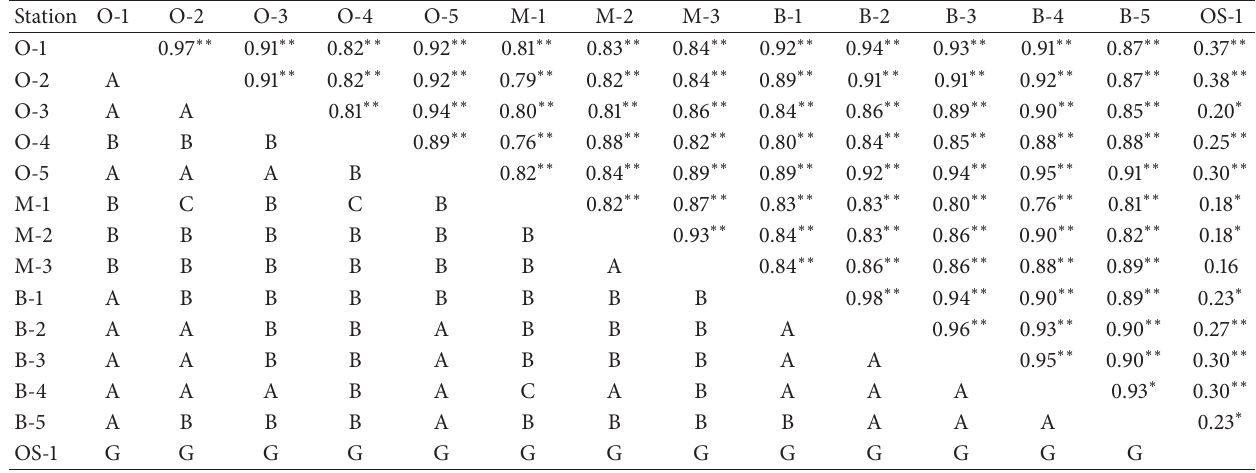
Table 6: 𝑝 value and quality for correlation coefficients for O invading case. Station